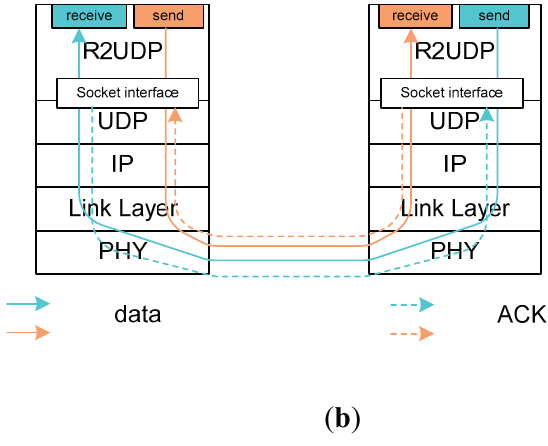
Figure 1. ( a ) Wireless transmission system; ( b ) Logical Reliable Channel.